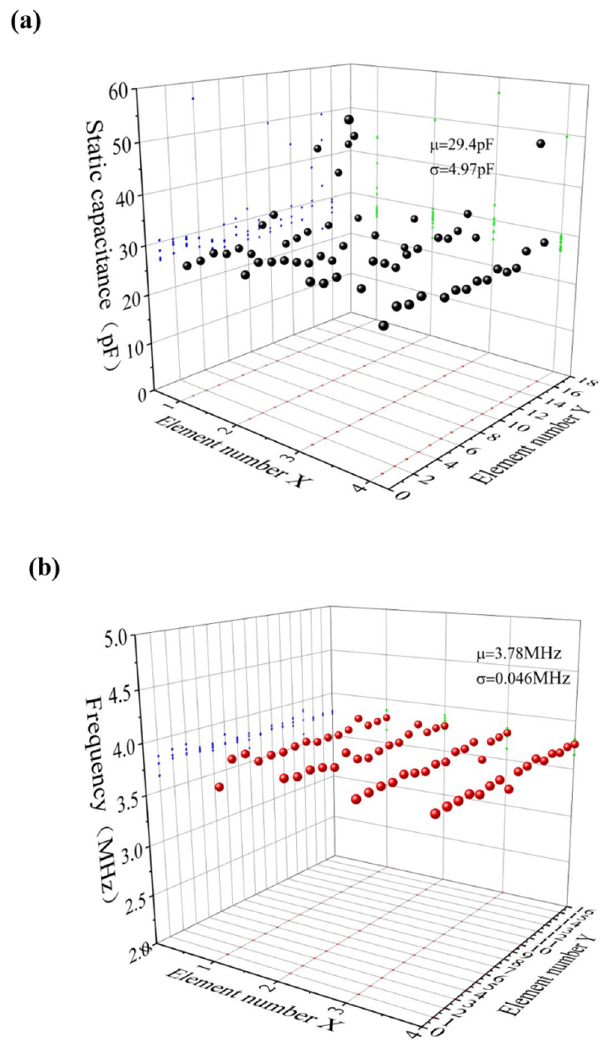
Figure 11. CMUT consistency test results. ( a ) Static capacitance distribution and mean variance of the 64 array elements; ( b ) Resonant frequency distribution and variance of the 64 array elements.